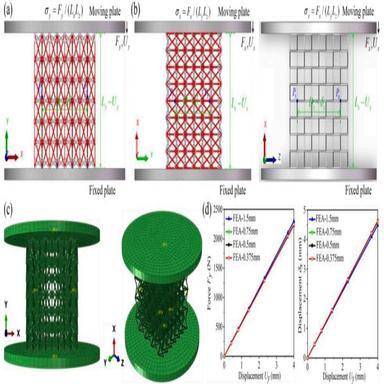
Schematic diagram of the finite element models of 3D DVH structures under compression, (a) compress the specimens along the ydirection and record axial force Fy and displacement Uy and transverse displacement δx, (b) compress the specimens along the x-direction and record Fx, Ux, δy and δz, (c) set the finite element models as the same of experiments and monitor the forces and displacements at reference points (RPs). (d) mesh convergence with global size from 1.5 mm to 0.375 mm (corresponding to elements pe